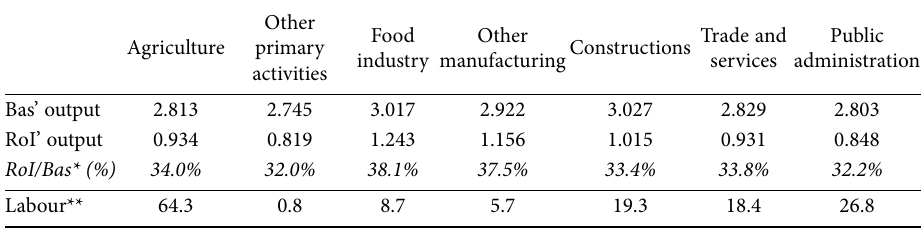
Table 3. Output multipliers in Basilicata’s economy